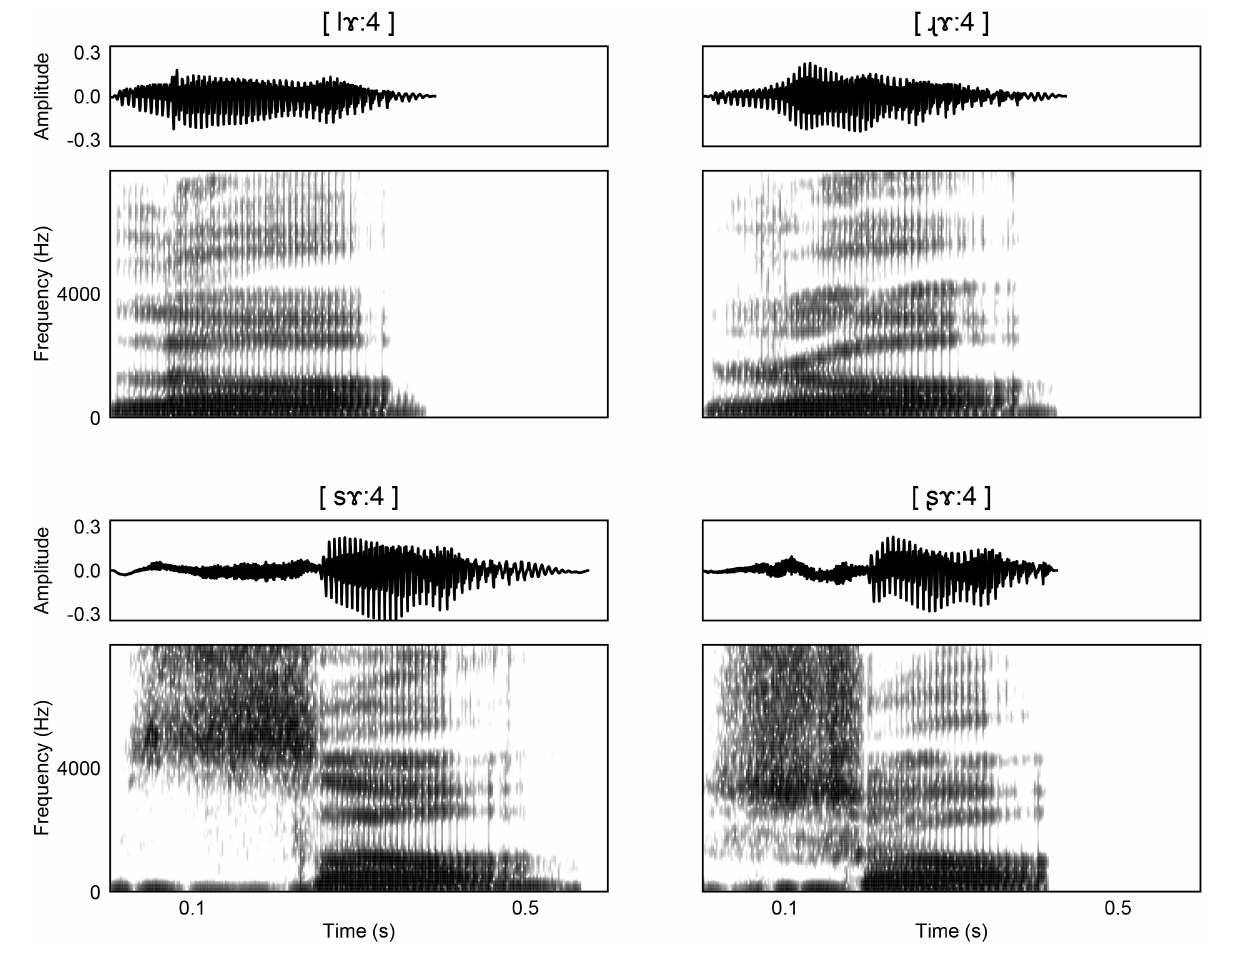
Frontiers in Human Neuroscience |